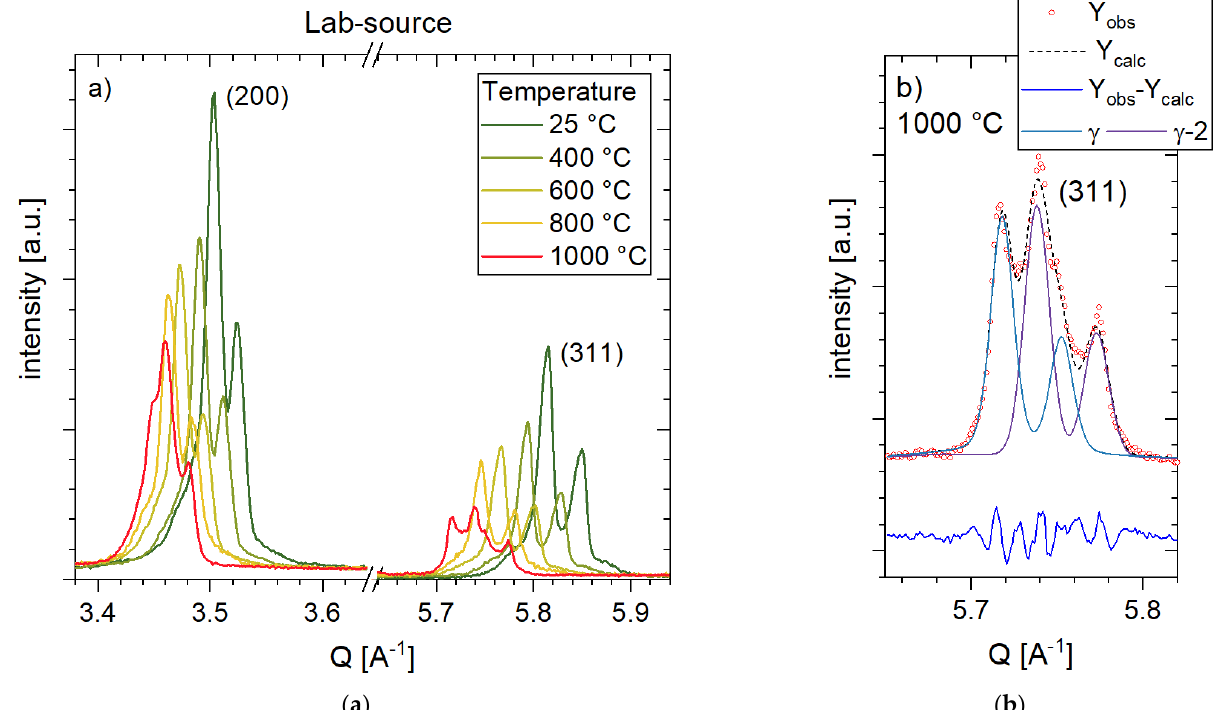
Figure 4. ( a ) Lab-source X-ray diffraction pattern of VDM ® Alloy 780 tested at different temperatures (25 °C to 1000 °C). In ( b ), a detailed view of Rietveld refinement at 1000 °C of the (311) diffraction peaks is provided: observed data (red circles), calculated data (black line), and difference plot (blue line). In this diffractogram, the simulated pattern for the γ and γ-2 phases is also shown.